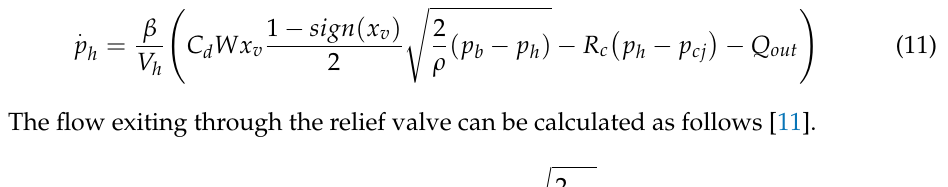
The flow exiting through the relief valve can be calculated as follows